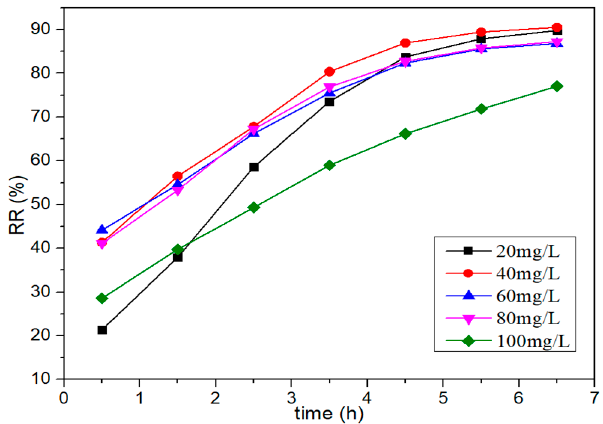
Figure 7. Effect of initial concentration on the removal rate of tetracycline. Reaction conditions: Tetracycline solution 40 mL, P-POPs-3 10 mg, dark reaction 0.5 h, light reaction 6 h.